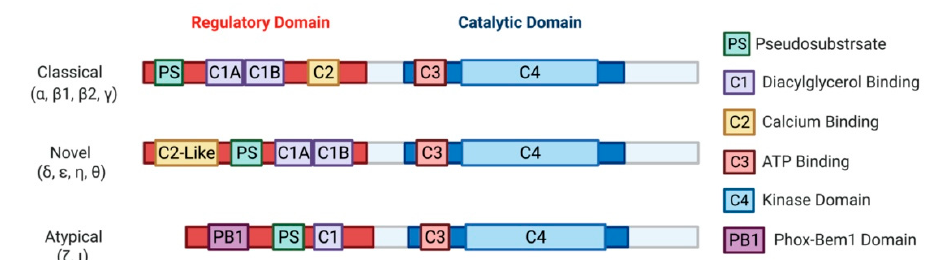
Figure 2. A schematic representation of PKC subfamily structural domains. Distinct PKC isozymes are categorized into classical, novel, or atypical PKCs based on N-terminal regulatory domain structure and have conserved C1-4 domains. Classical PKC α , β 1, β 2, γ are activated by DAG and calcium through binding with C1A-C1B and C2 domain, respectively. Novel PKC isoforms δ , ε , η , θ are DAG dependent but calcium independent for their activation, as the C2-like domain cannot bind calcium. Atypical PKC ζ , ι do not respond to calcium or DAG. All PKC isozymes have a pseudosubstrate (PS) domain involved in kinase auto-inhibition. The C-terminal catalytic domain is highly homologous between all the PKC isozymes and consists of an ATP binding C3 domain and a C4 kinase domain.